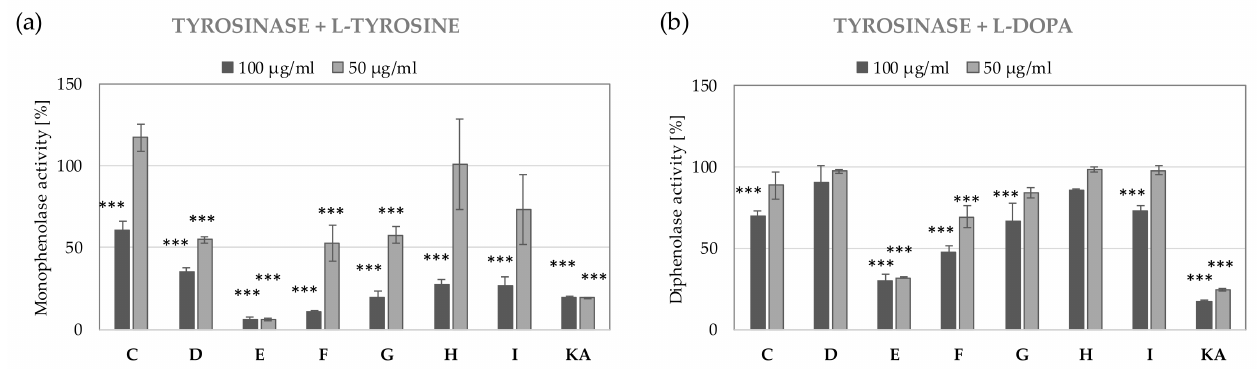
Figure 4. Inhibition of monophenolase ( a ) and diphenolase ( b ) activity of tyrosinase by C-I fractions of closed flower extract (R3) of R. platyacantha KA- kojic acid, values on graphs represent mean ± SD ( n = 3), *** p <